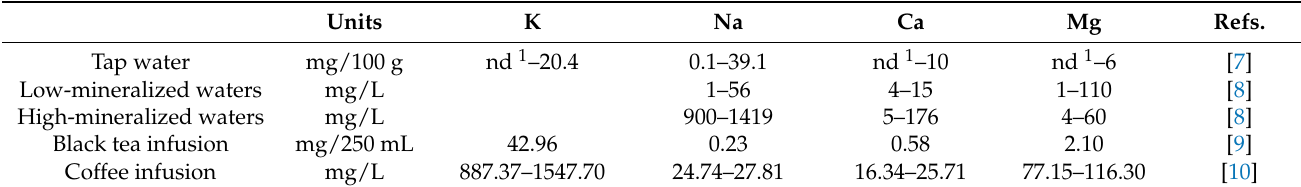
Table 2. Examples of the element